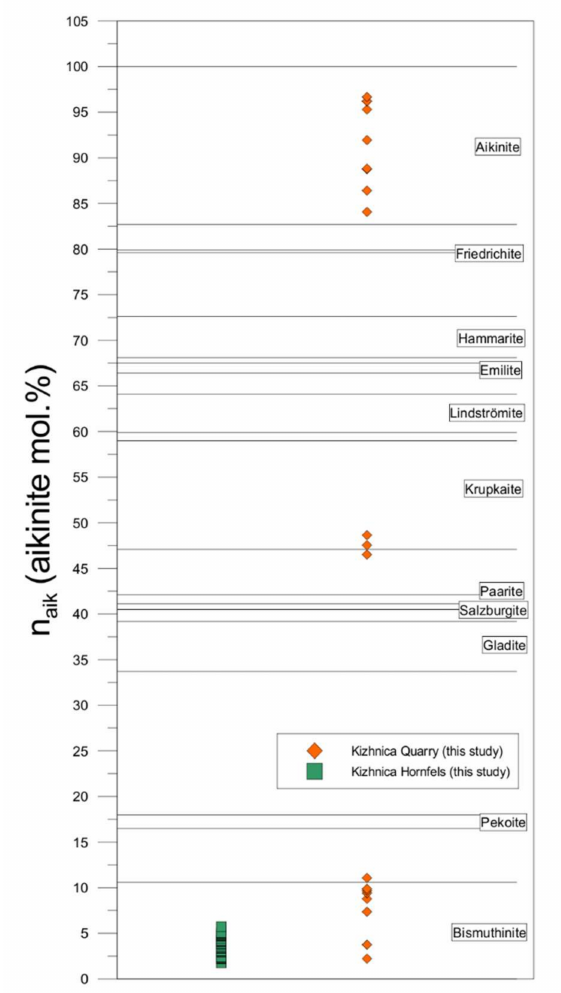
Figure 6. Position of the species of the bismuthinite-aikinite series from the Kizhnica area determined by their n aik after